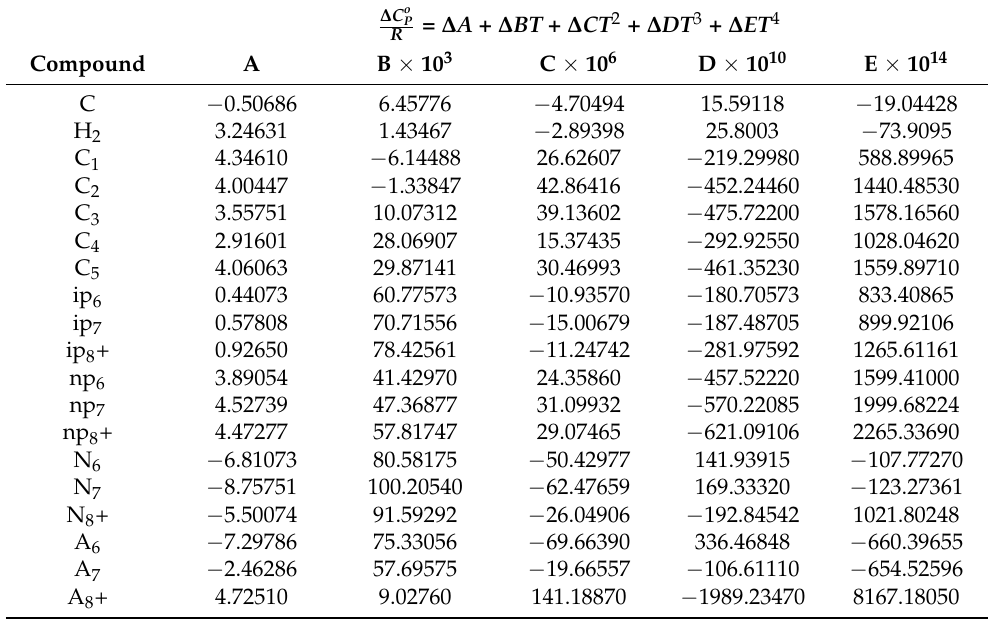
Table 3. Constants for ideal gas heat capacity